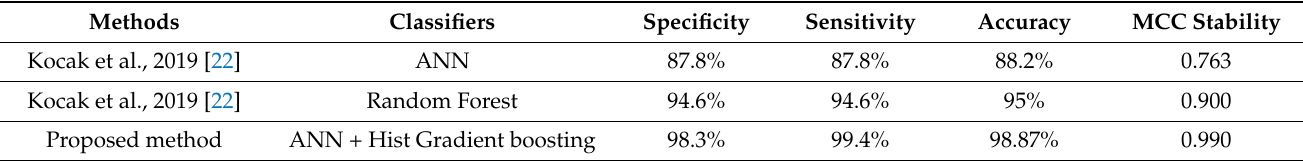
Table 5. Comparison of the proposed method with other techniques.